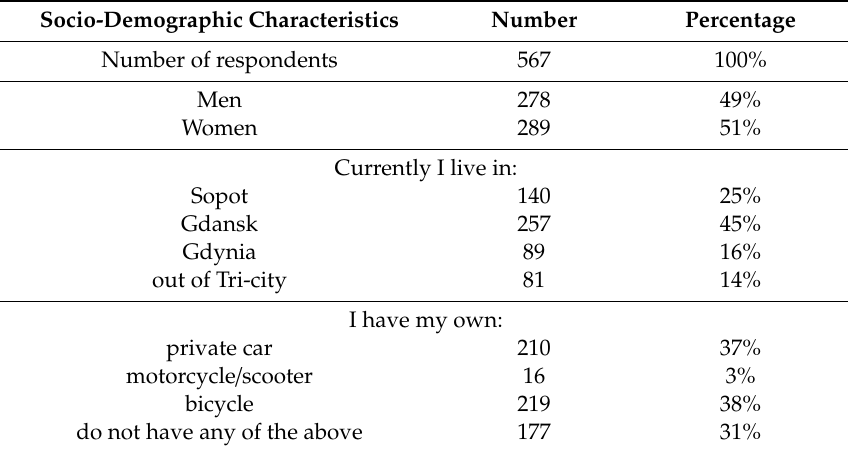
Table 2. Basic information on socio-demographic characteristics.